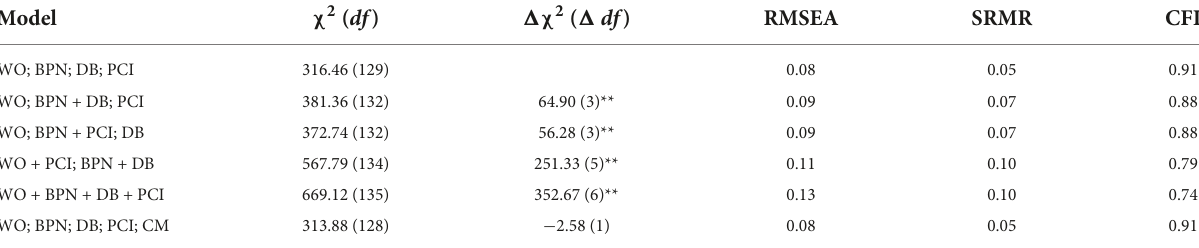
TABLE 2 Results of confirmatory factor analyses.